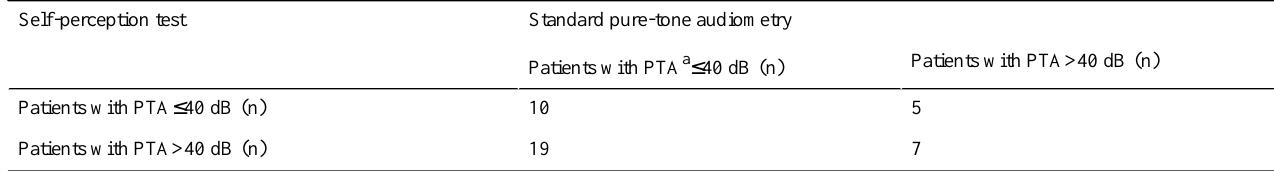
Table 2. Accuracy of self-perception as a screening test compared to the standard pure-tone audiometry (N=41).